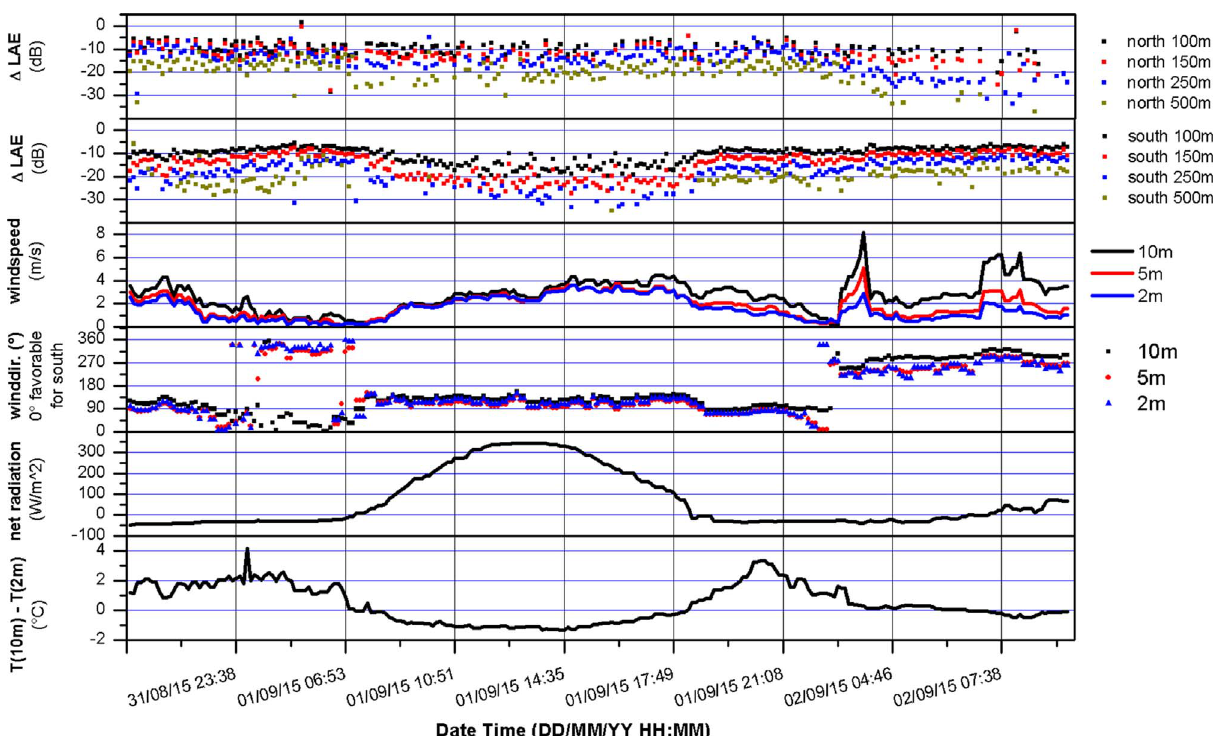
Figure 4. Aderklaa: A-weighted sound exposure level differences D L A,E for the all train passages at different distances from the railway line relative to the reference point and meteorological data.